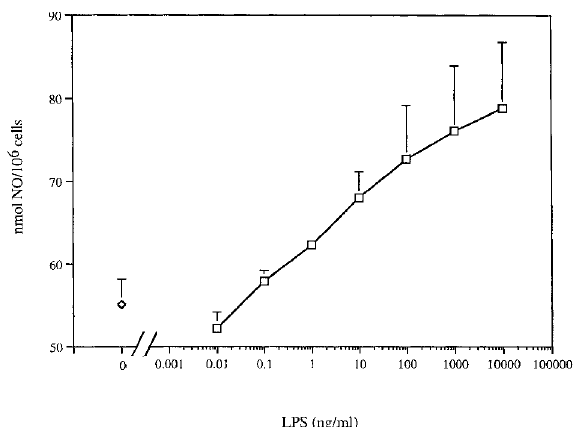
FIG. 1. Effect of increasing concentrations of LPS on NO release from rat AM in vitro . Data are presented as mean ± SEM, n = 4; Open squares represent LPS-stimulated NO release; Open diamond represents basal (unstimulated) NO release.